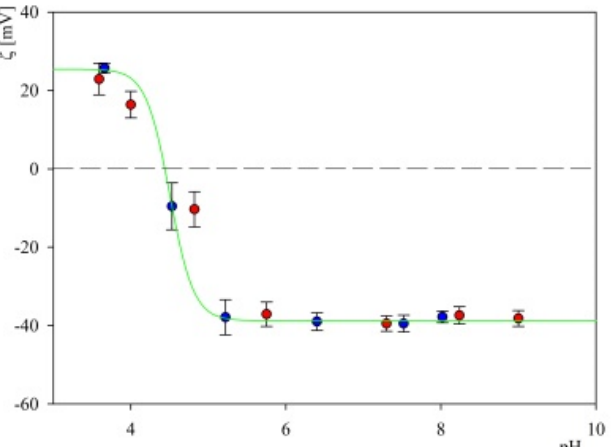
Figure 10. Dependence of the zeta potential of the S1R corona on S800 particles with the coverage equal to 3 mg m ‐ 2 on pH. The points represent experimental data acquired using the LDV method for 10 mM NaCl, ( ● )—pH increase; ( ● )—pH decrease, interpolated by a green line.